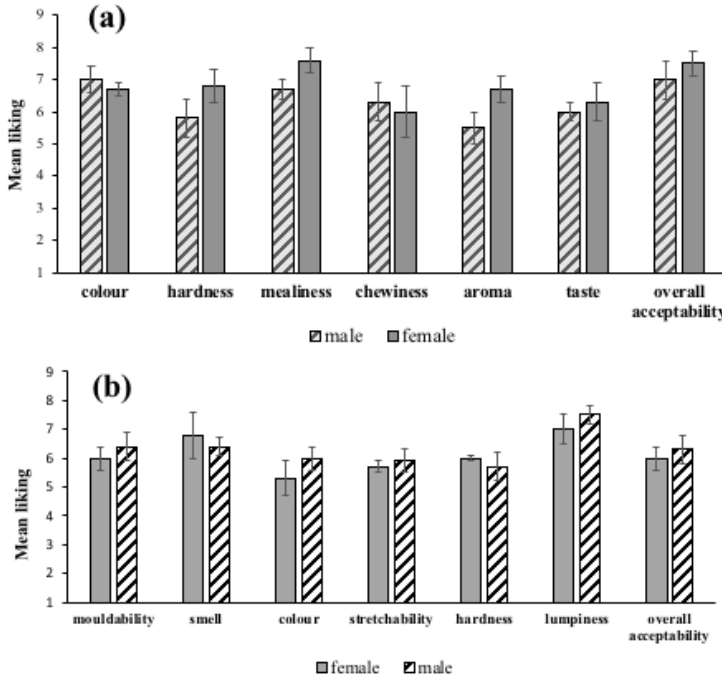
Foods 2023 , 12 , x FOR PEER REVIEW Figure 3. Sex-disaggregated preferences for ( a ) boiled and ( b ) pounded Dioscorea alata.